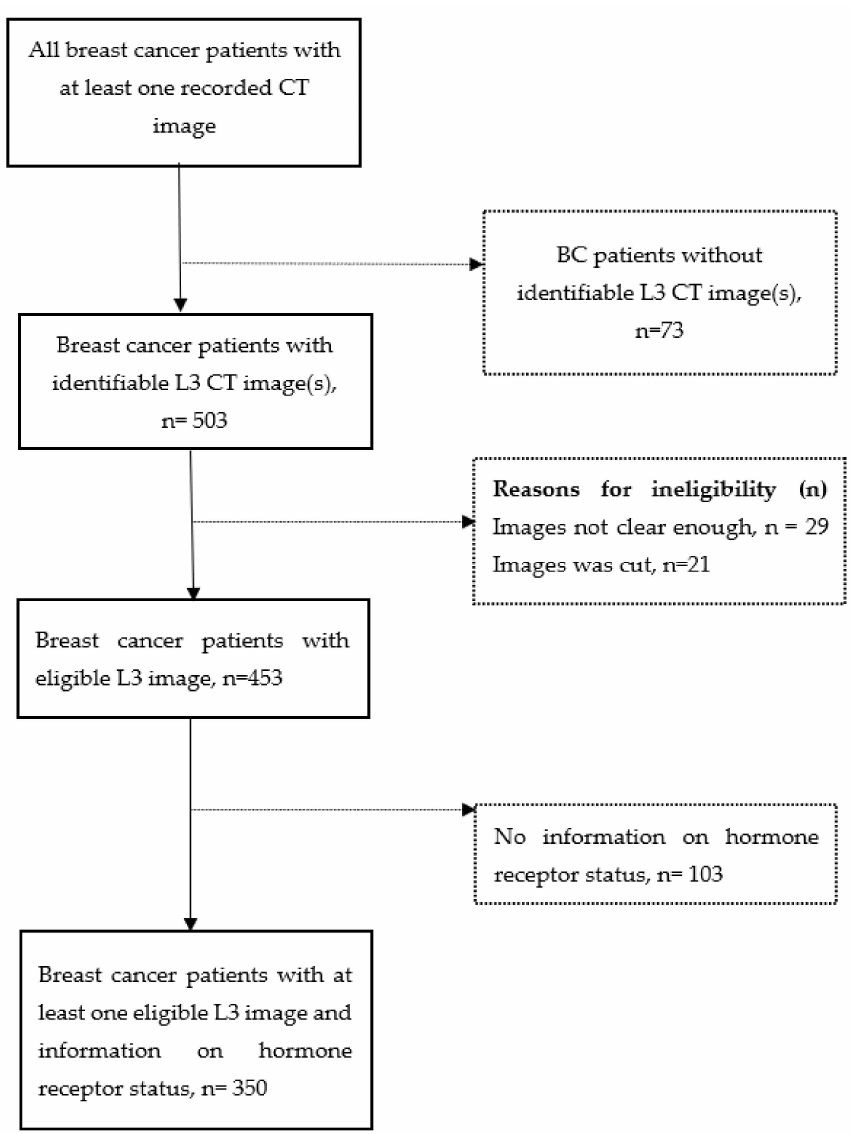
Figure 1. Participants selection diagram. Dash line arrow and dash line square indicate exclusion. Participants were excluded if they had missing data on either estrogen receptor status, progesterone receptor status, or human epidermal growth factor receptor 2